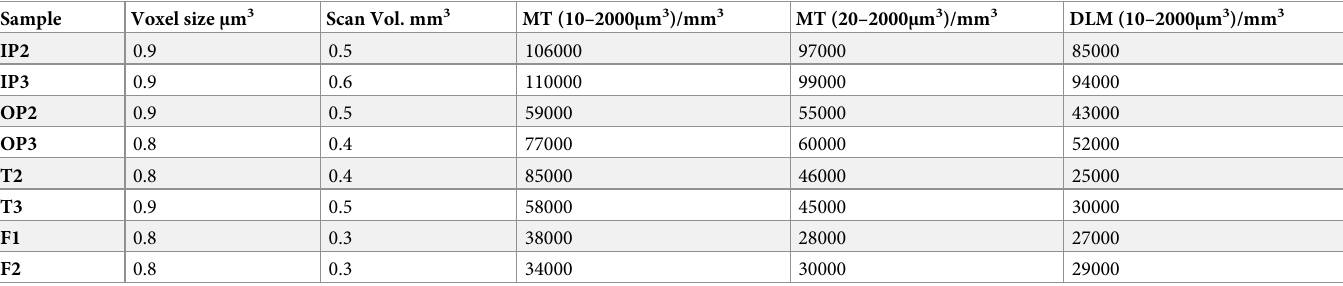
Table 1. Numbers of OL from all different